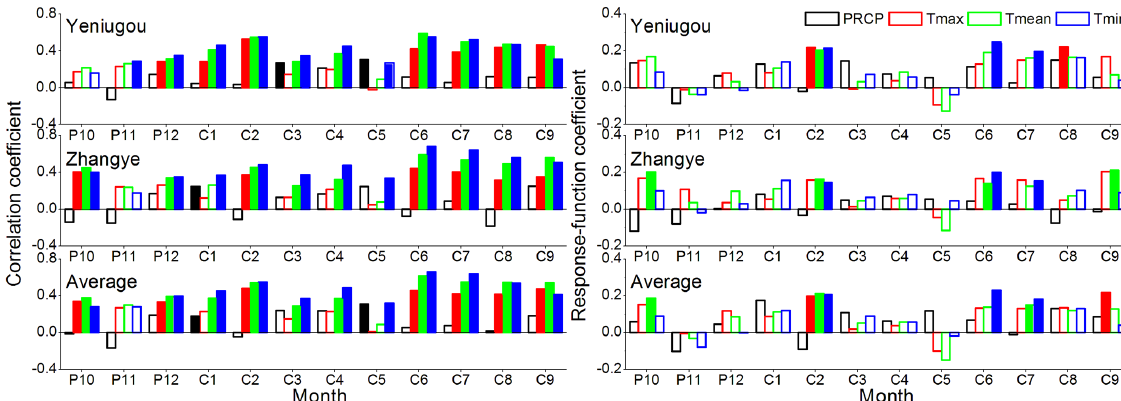
Figure 4. Correlation (left) and response-function (right) analysis plots between the HY chronology and the monthly climatic data from Yeniugou (top), Zhangye (middle) and the averages of the two stations (bottom). Months P10 through to P12 are October through to December of the previous year, and months C1 through to C9 are January through to September of the current year. The filled colour bars mean the significance level of 0.05. The monthly climatic data include monthly mean temperature ( T mean ), monthly minimum temperature ( T min ), monthly maximum temperature ( T max ), and monthly total precipitation (PRCP).